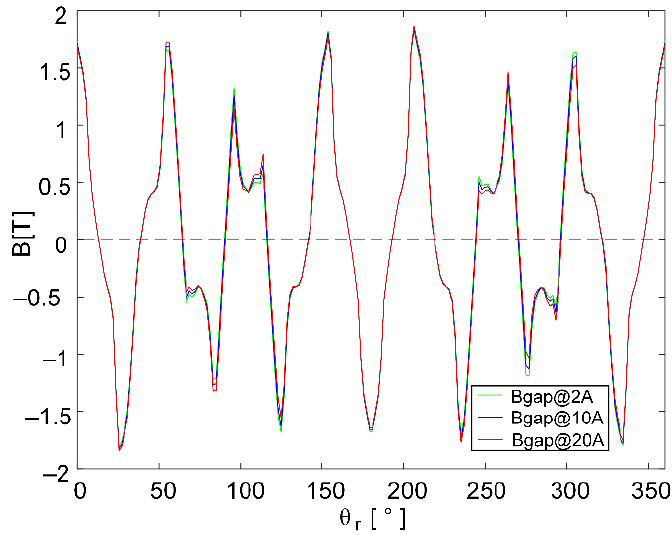
Figure 5. Flux density in the air gap at different supply currents.